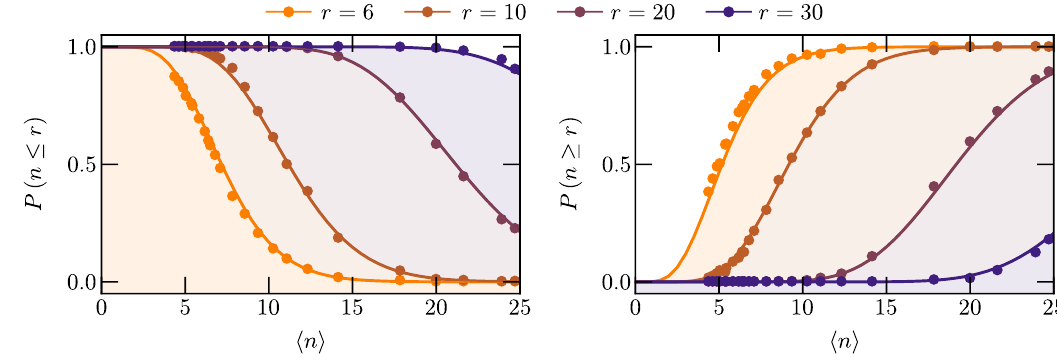
Figure 4 . Cumulative probability for P ( n ≤ r ) (Left) and P ( n ≥ r ) (Right) in the tails of the vortex number distribution, with respect to the average vortex number h n i . Numerical dots obtained for different quench times match the theoretical predictions eq. (5.1) and eq. (5.2) (solid lines) derived from an EP